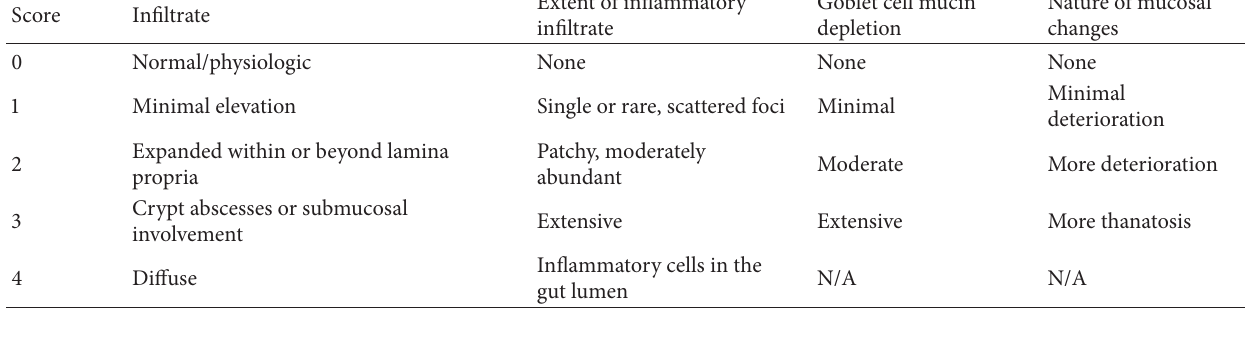
Table 3: The histologic activity index (HAI) scoring system for inflammation-associated histological changes in the colon.